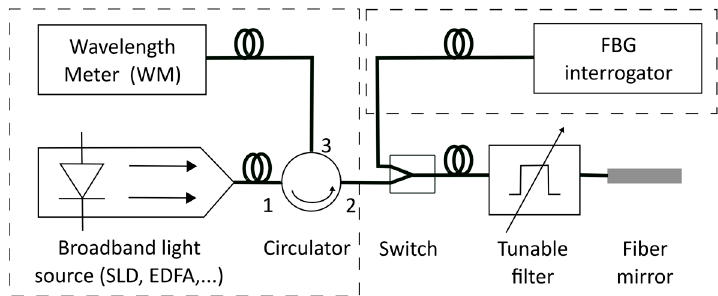
Figure 2. Setup of the first calibration method, based on a simulated fiber Bragg grating.